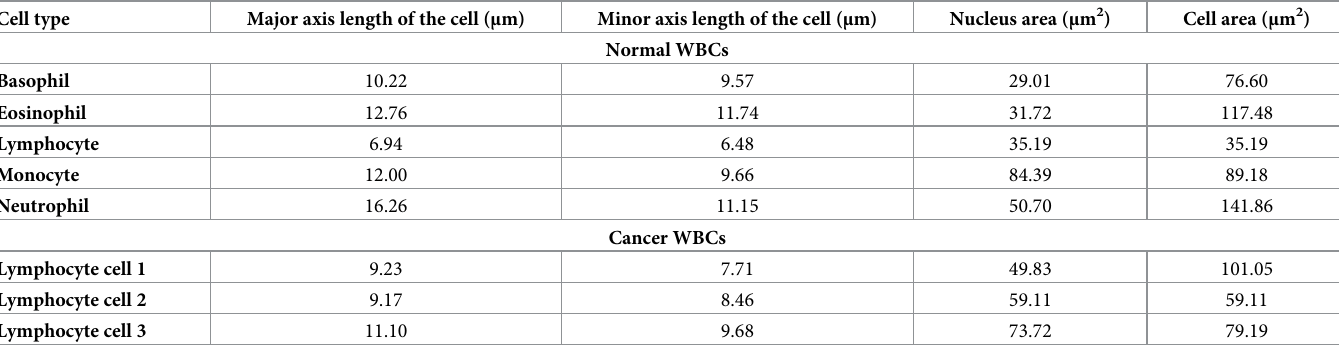
Table 1. The measured characteristics of the normal and the cancer WBCs.